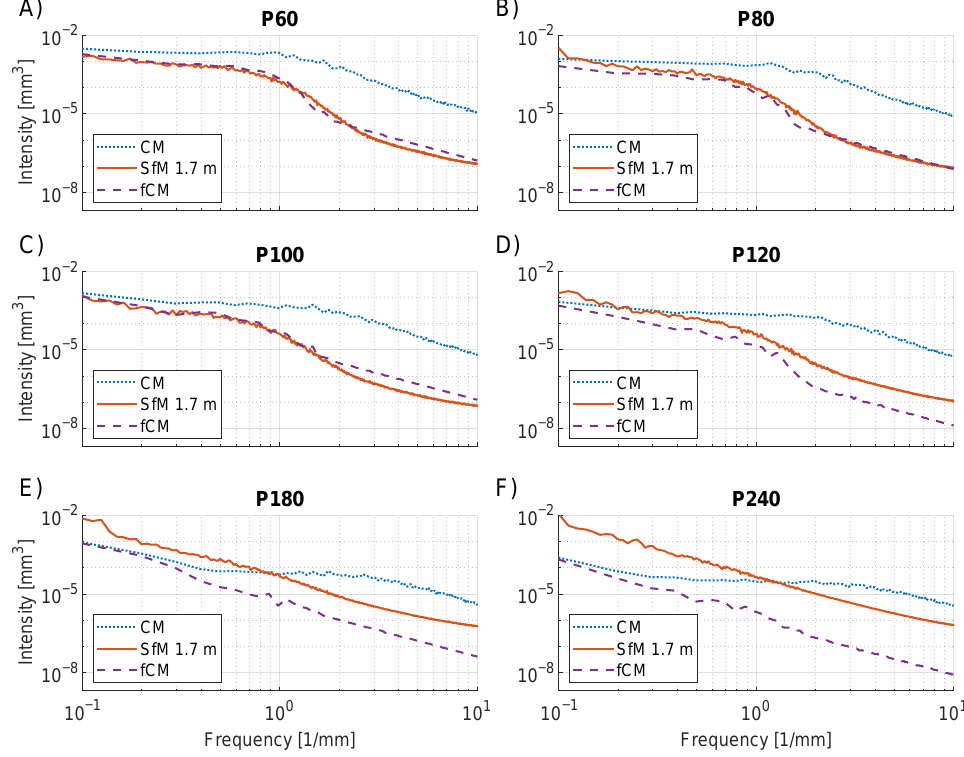
Figure 10. PSD analysis of CM (dotted line), SfM at 1.7 m range (full line), and fCM (dashed line) topographies of sandpaper artifacts of grit sizes P60–P240. The average of 1D PSD curves for each line in the DEM is shown on a log–log scale. ( A ) P60. ( B ) P80. ( C ) P100. ( D ) P120. ( E ) P180. ( F )